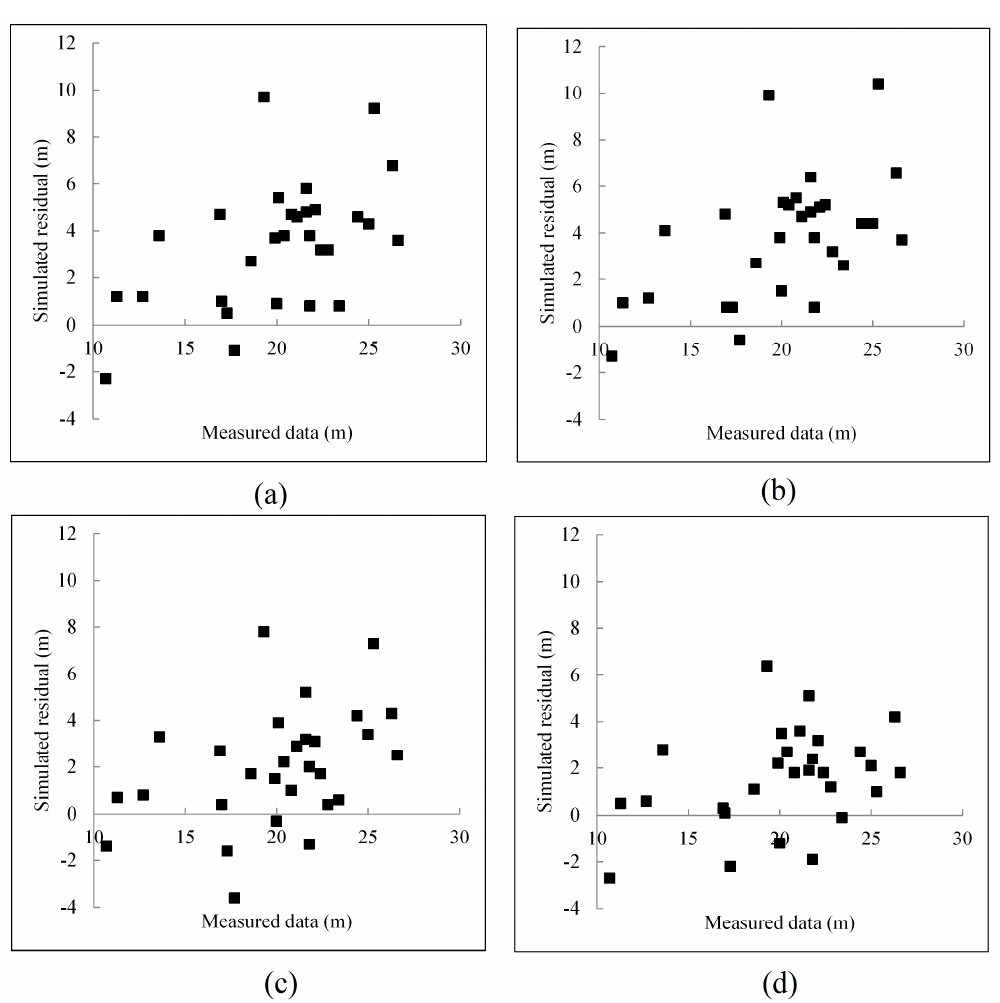
Figure 6. Relationship between the measured plot-level maximum tree heights and simulated residuals, i.e., difference between measured and simulated plot-level maximum tree height, for the 30 plots. ( a ) Mean filter; ( b ) median filter; ( c ) HPM; and ( d ) our method.